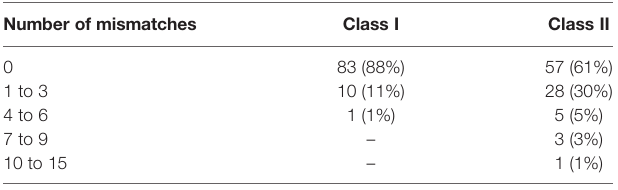
TABLE 2 | Absolute agreement in the number of eplet mismatches using NGS versus LD-typing. Number of mismatches